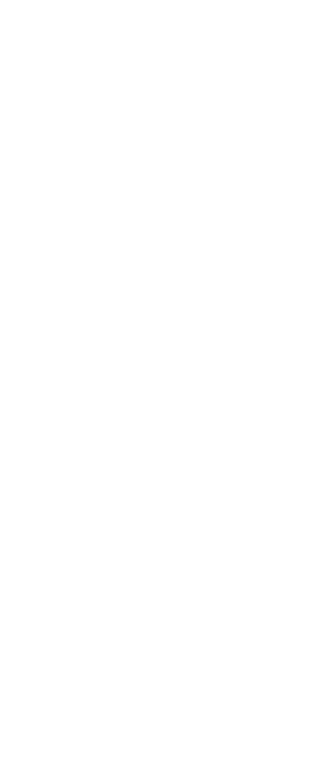
FIGURE 4 | Expression of heat shock protein encoding genes was higher in honey bees fed sucrose syrup containing thyme oil, fumagillin, or clothianidin. The relative expression of three genes encoding heat shock proteins ( pl2, hsp90, hsc70-4 ) was assessed using qPCR in mock or virus-infected bees fed sucrose syrup only or sucrose syrup containing additivities (i.e., thyme oil, fumagillin, or clothianidin). The DD Ct method with normalization to rpl8 in mock or virus-infected bees fed sucrose syrup diet was utilized to determine the relative gene expression. (A) Protein lethal(2)essential for life-like ( pl2 ) expression in virus-infected bees (i.e., FHV, DWV, SINV) fed sucrose syrup containing thyme oil (0.16 ppb), fumagillin (25 ppm or 75 ppm) or clothianidin (1 ppb or 10 ppb) was higher compared to expression in bees fed sucrose only. In mock-infected bees, pl2 expression in bees fed sucrose syrup containing stimulant (0.16 ppb thyme oil) or 10 ppb clothianidin was similar to expression levels in bees fed sucrose only, whereas pl2 expression was higher in bees fed sucrose syrup containing fumagillin (25 ppm or 75 ppm) or 1 ppb clothianidin. (B) Heat shock protein 90 ( hsp90 ) expression was higher in majority of the treatment groups, including virus- or mock-infected infected bees fed augmented sucrose syrups compared to bees fed non-augmented sucrose syrup except in SINV-infected bees fed thyme oil or 75 ppm fumagillin, which had similar hsp90 expression levels to bees fed sucrose only. (C) Heat shock 70-kDa protein cognate 4 ( hsc70-4 ) expression was higher in the majority of treatment groups including mock and virus-infected bees fed sucrose syrup containing either thyme oil (0.16 ppb), fumagillin (25 ppm or 75 ppm) or clothianidin (1 ppb or 10 ppb), except in SINV-infected bees fed sucrose syrup containing thyme oil, which had hsc70-4 expression levels similar to the controls. Data were analyzed by a pairwise Wilcoxon Rank Sums with a Benjamini – Hochberg correction for multiple comparisons. Asterisks indicate a signi fi cant change in gene expression compared to sucrose only control; signi fi cance levels: * p < 0.05; ** p < 0.005; *** p < 0.0005. This fi gure shows representative biological replicate for pl2 expression (i.e., rep1). The data for all three biological replicates for pl2 are presented in Supplemental Figure S6 and raw data are included in Supplemental Tables S11 – S16